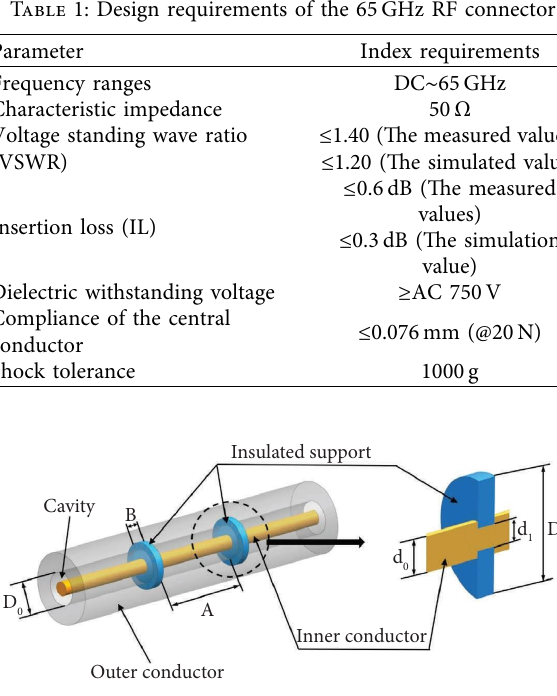
Figure 1: Simplifed structure of a millimeter-wave